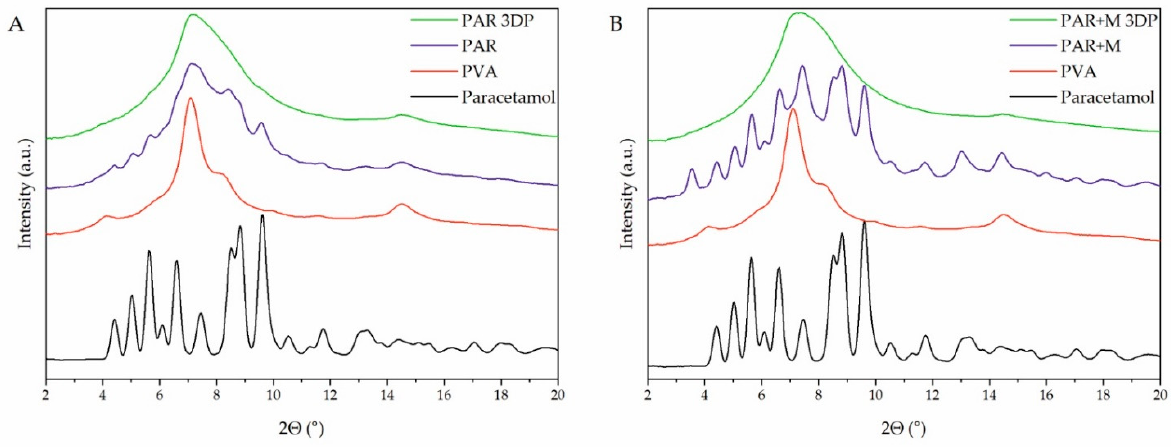
Figure 6. XRPD diffractograms of raw paracetamol, PAR ( A ) and PAR + M ( B ) filaments, and 3D printed tablets made of PAR ( A ) and PAR + M ( B ) filaments.